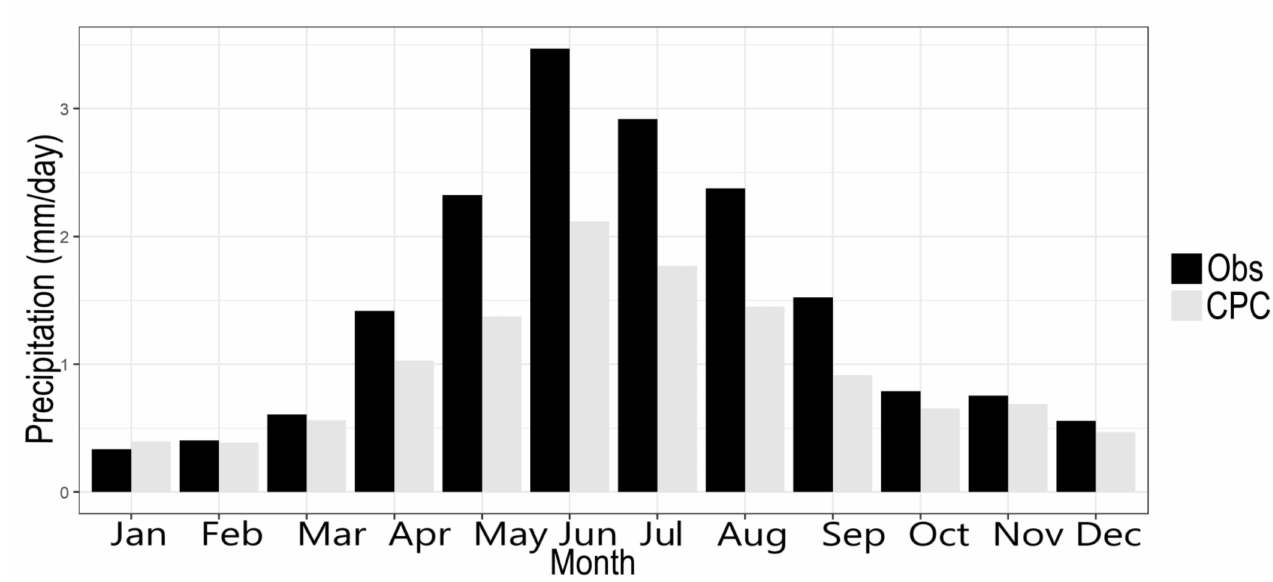
Figure 1. Annual cycle of rainfall from station data (obs) and CPC dataset for the 1979–2020